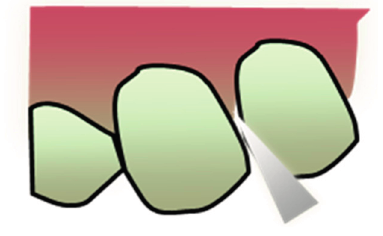
Figure 1. Schematic view of GCF collection